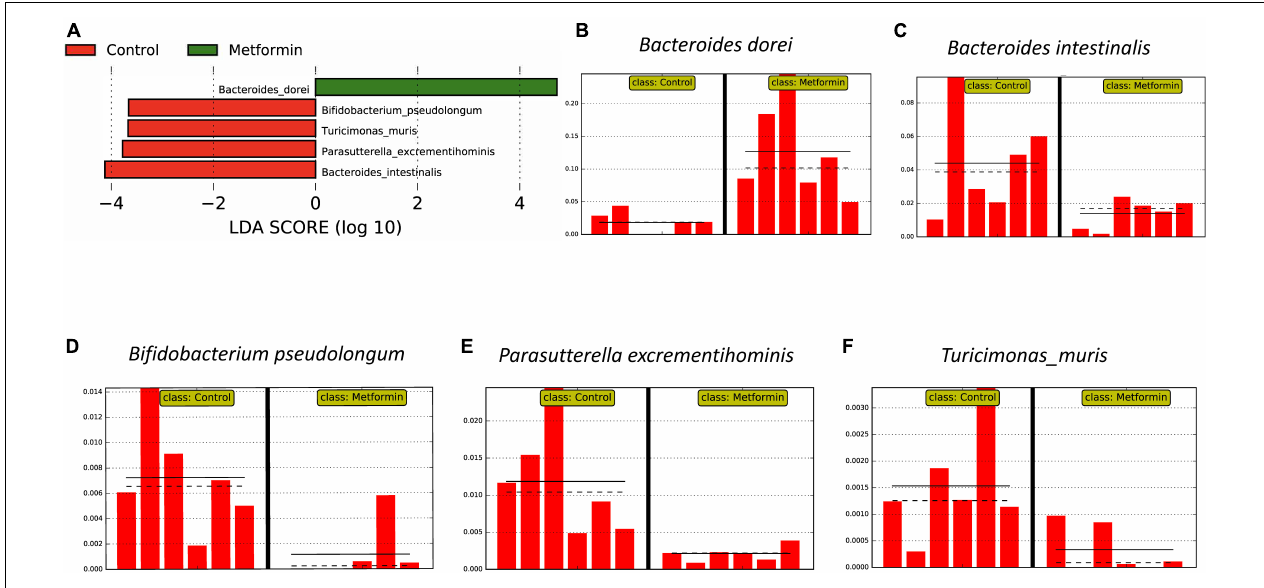
FIGURE 3 | Differentially abundant bacterial taxa as determined by LEfSe analysis on MetaPhlAn 3 output. (A) Linear discriminant analysis (LDA) score plot of differential taxa associated with the Control and Metformin groups. Differential feature plots for the respective taxa are shown across samples: (B) Bacteroides dorei , (C) Bacteroides intestinalis , (D) Bifidobacterium pseudolongum , (E) Parasutterella excrementihominis , and (F) Turicimonas muris